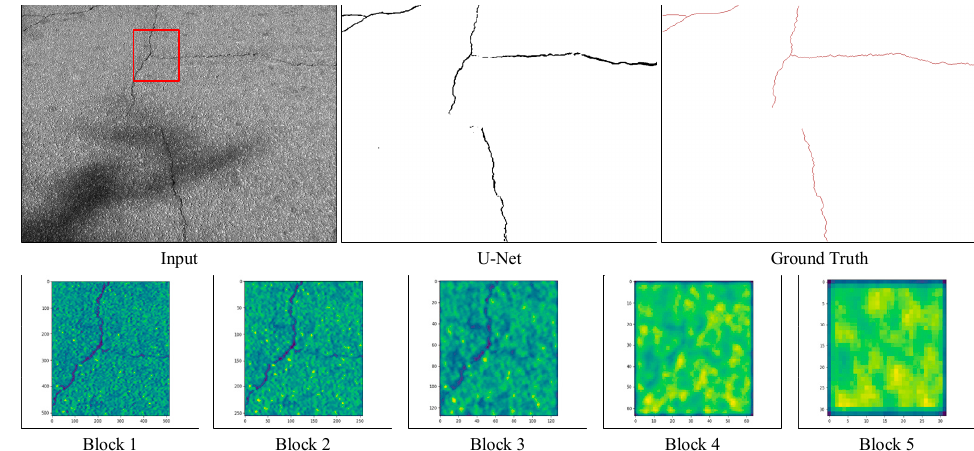
Figure 1. A real example of distress segmentation using U-Net. The second row shows the feature maps of blocks with di ff erent depths in U-Net (for the image patch denoted by the rectangle in the maps of blocks with different depths in U-Net (for the image patch denoted by the rectangle in the input image). input